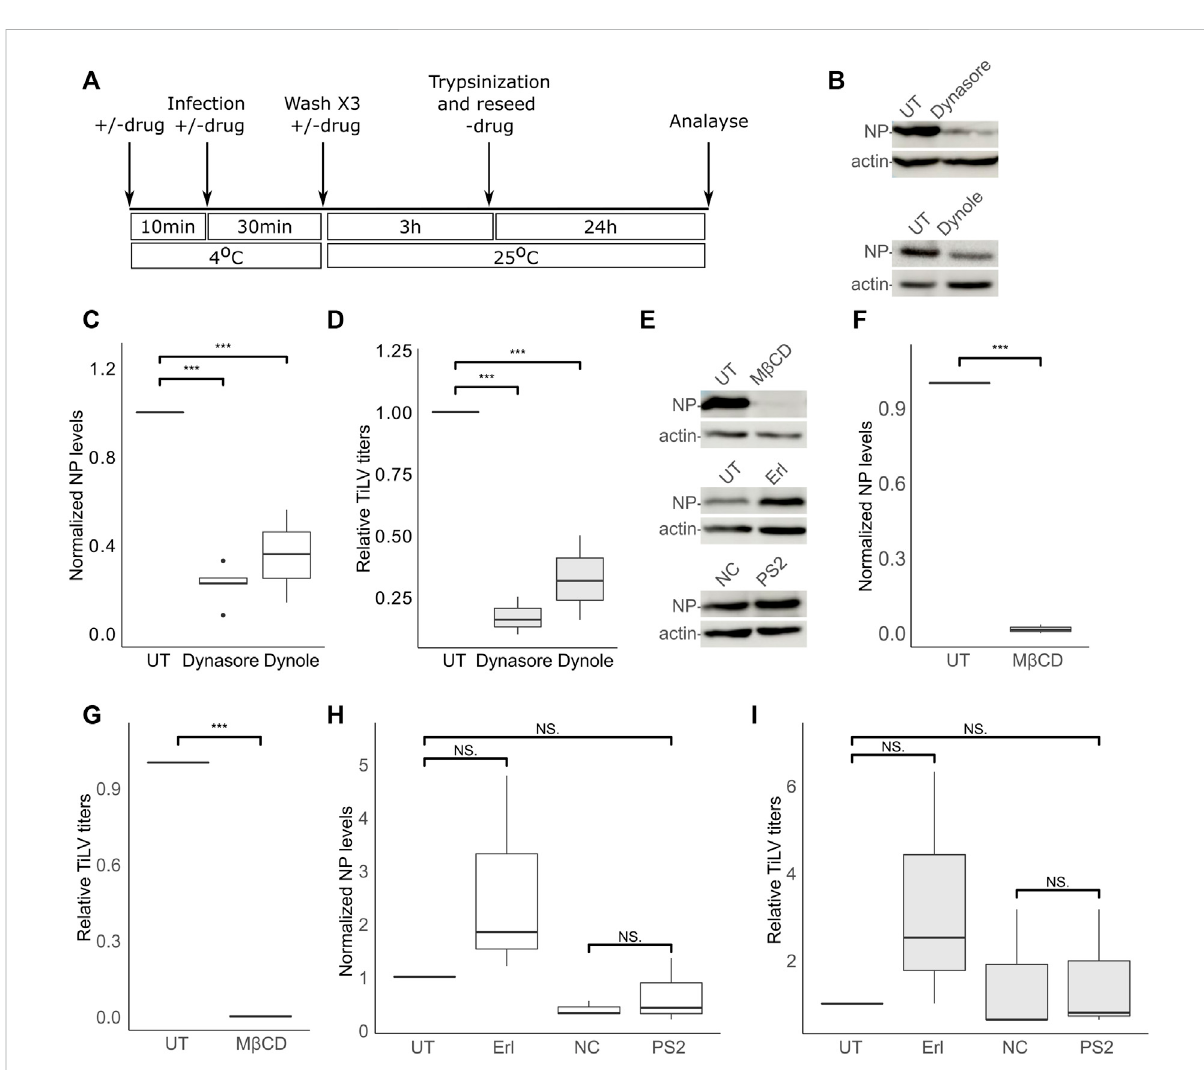
TiLV entry is dynamin- and cholesterol-dependent, and clathrin-independent. (A) A schematic timeline and procedures used to analyze the effects ofinhibitory drugs onTiLV entry into tilapiacells. (B – I) Analyzes,according to (A) , ofTiLV-infected tilapia TmBcells, untreated (UT) or treated with dynasore, dynole, M β CD, erlotinib (Erl), pitstop 2 (PS2), or the negative control (NC) of the latter. (B,E) Immunoblots of cellular NP and actin of representative experiments. (C,D,F – I) Boxplot graphs of measurements of three independent experiments for each indicated drug. (C,F,H) Cellular NP levels normalized to actin levels (quanti fi ed by densitometry). (D,G,I) Relative TiLV titers (calculated as TCID 50 /ml and shown as the ratio of the titer of the treated to untreated cultures). *, p ≤ 0.05; **, p ≤ 0.01; ***, p ≤ 0.001; NS, non-signi fi